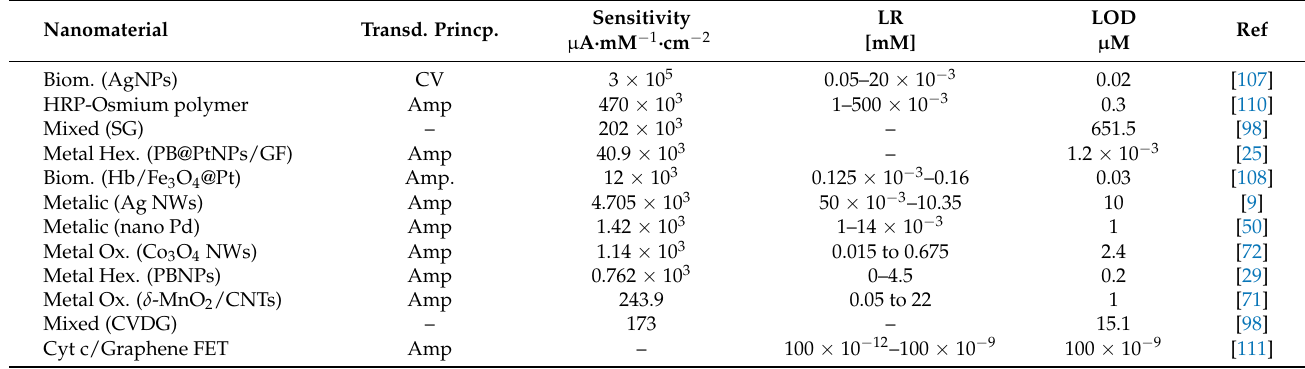
Figure 15. Schematic representation of the Cyt c modified single-layered graphene FET sensor for ultrasensitive H 2 O 2 detection. ( a ) the overall fabrication process for graphene FET sensor platform. The fabrication strategy is first performed to obtain single-layered graphene-based FET platform for a high-performance sensor. The second step involves the conjugation of the Cyt c with surface- modified graphene via 1,5-diaminoaphthanlene (DAN). Then, this sensor platform was utilized for the detection of the H 2 O 2 in real-time manner; ( b ) Cyt c-conjugated graphene FET sensor. Cyt c, which contains a heme structure as a catalytic site, is able to convert the value of the current via electron transport by H2O2-induced oxidation. With permission from [111]. Table 5. High sensitivity nanomaterials for peroxide